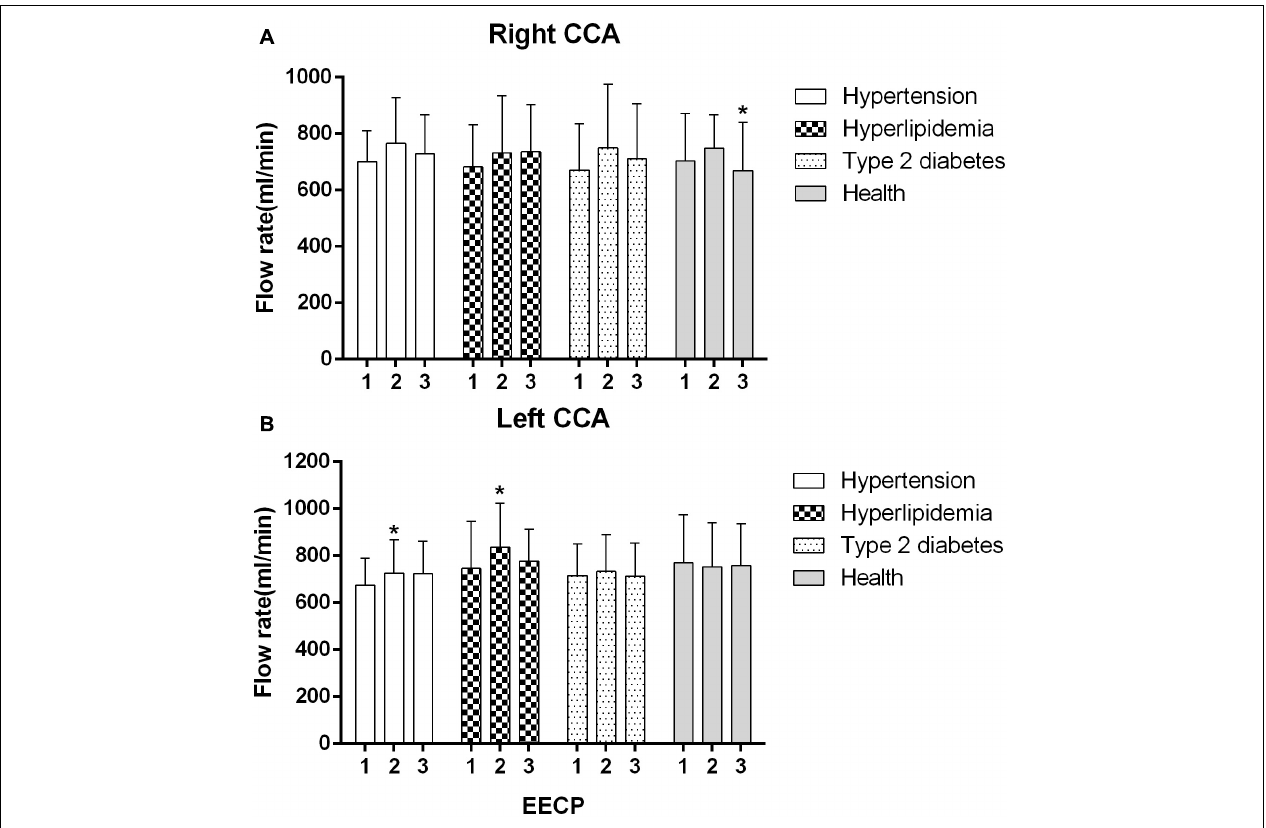
FIGURE 7 | Mean flow rate (FR) of the four groups before, during and after 45-min EECP. * P < 0.05 during EECP vs.